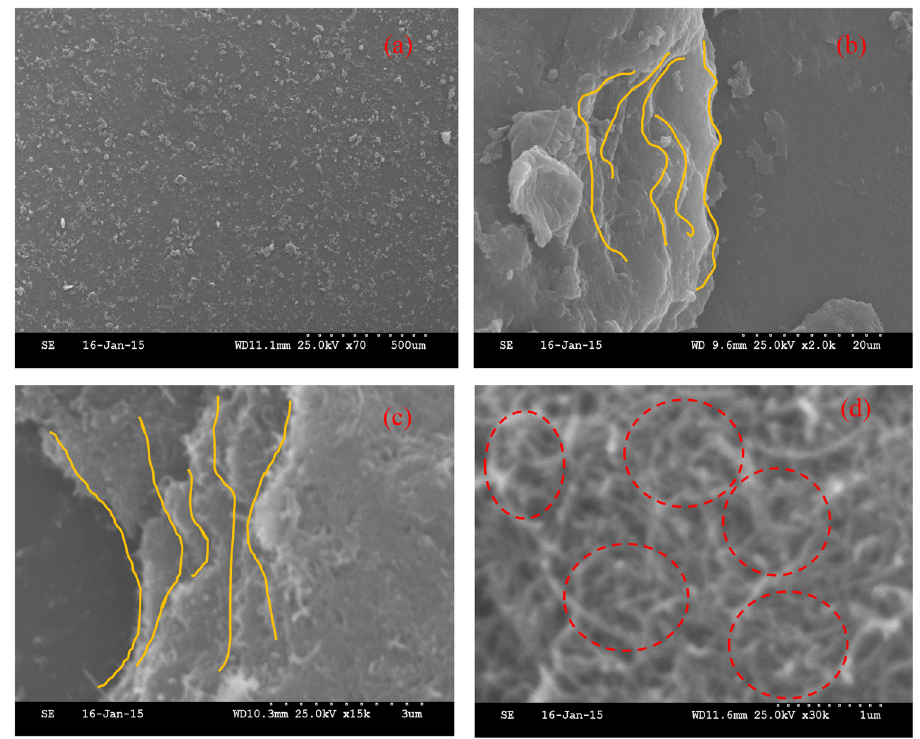
Figure 4: SEM images of self - assembled nine - double - layer CNTFS: ( a ) × 70, ( b ) × 2.0 k, ( c ) × 15 k, and ( d ) × 30 k ( yellow line – assembled layer interface; dashed red circle – CNT distribution network ) .